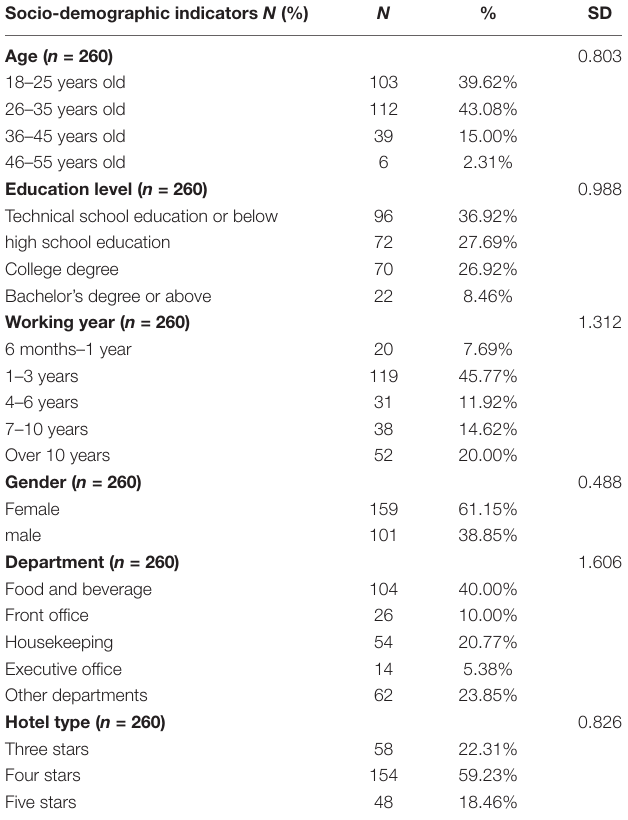
TABLE 1 | Participants’ profile ( n =